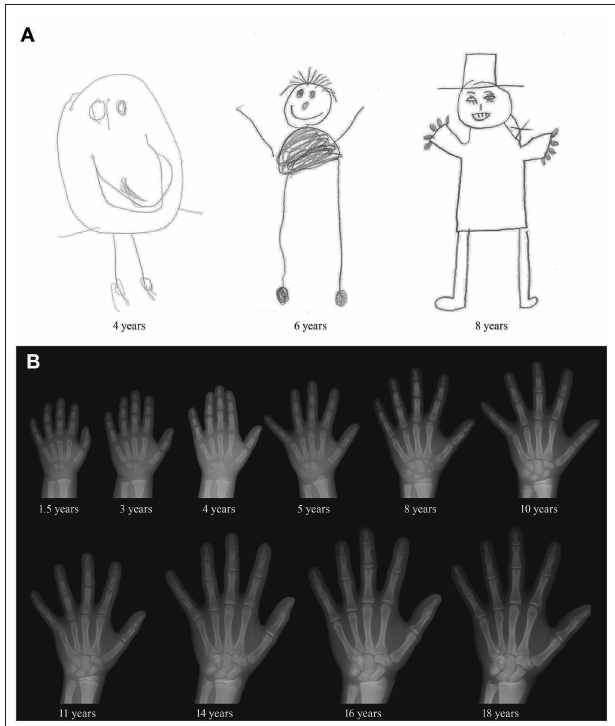
FIGURE 7 | Illustration of drawings and hand X-rays. (A) Draw-a-Person-Test of one male participant at 4, 6, and 8 years of age. (B) Serial hand X-rays of one male participant.